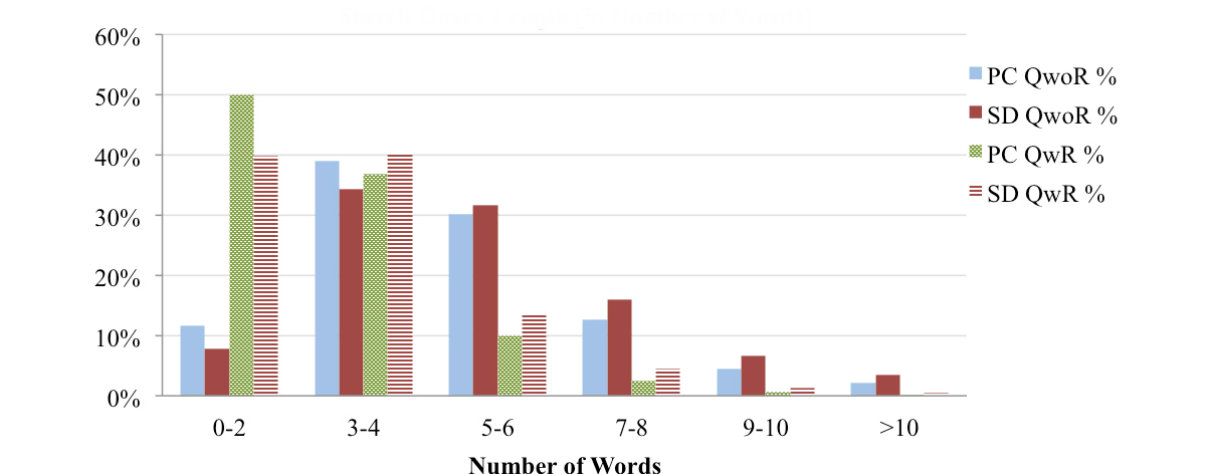
Figure 3. Distribution of the search queries by number of words and